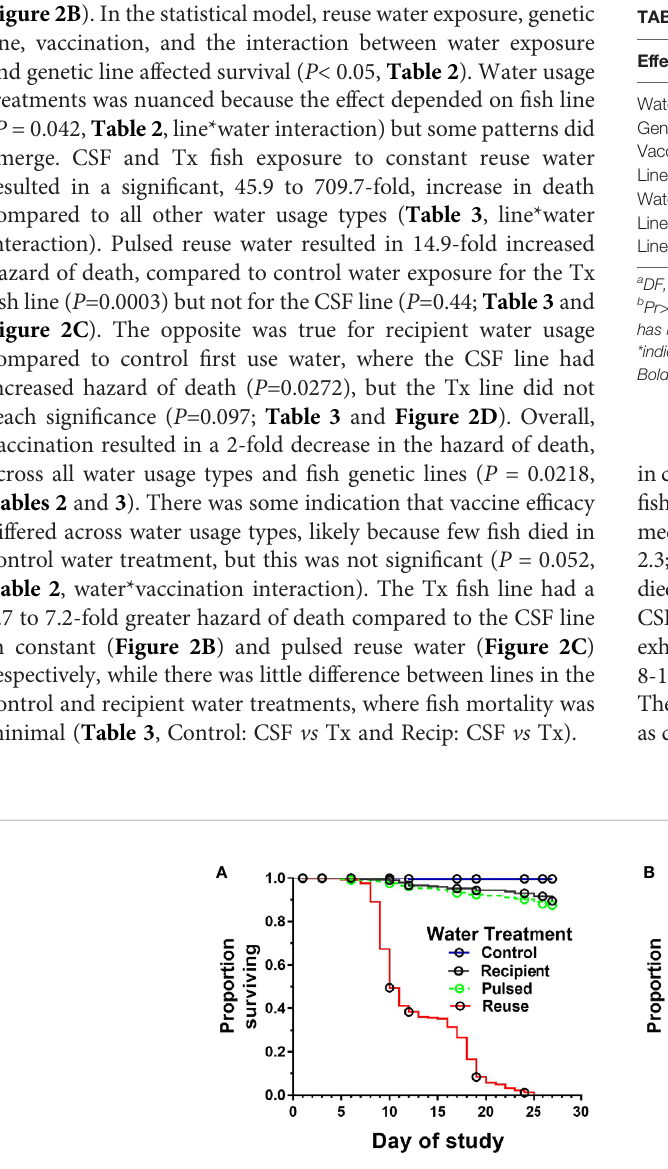
FIGURE 2 | Survival of two genetic lines of rainbow trout exposed to various water reuse paradigms and IHNV vaccination. Plots show proportion of fi sh surviving different water treatments. Overall comparison of water treatments in which genetic line and vaccine treatments were collapsed (A) , Constant reuse water exposed group comparing genetic line and treatment (B) . Note the Constant and Donor groups were combined by genetic line and vaccine status. Pulsed reuse water exposed group comparing genetic line and vaccine treatment (C) , and Recipient group comparing genetic line and vaccine treatment (D)